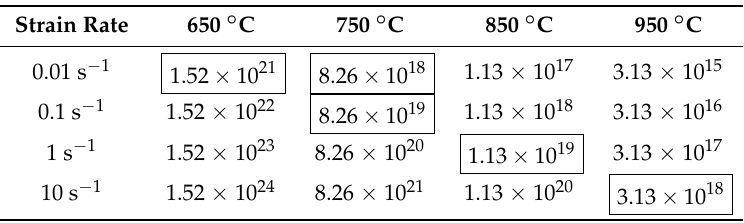
Table 5. Z parameters under various deformation